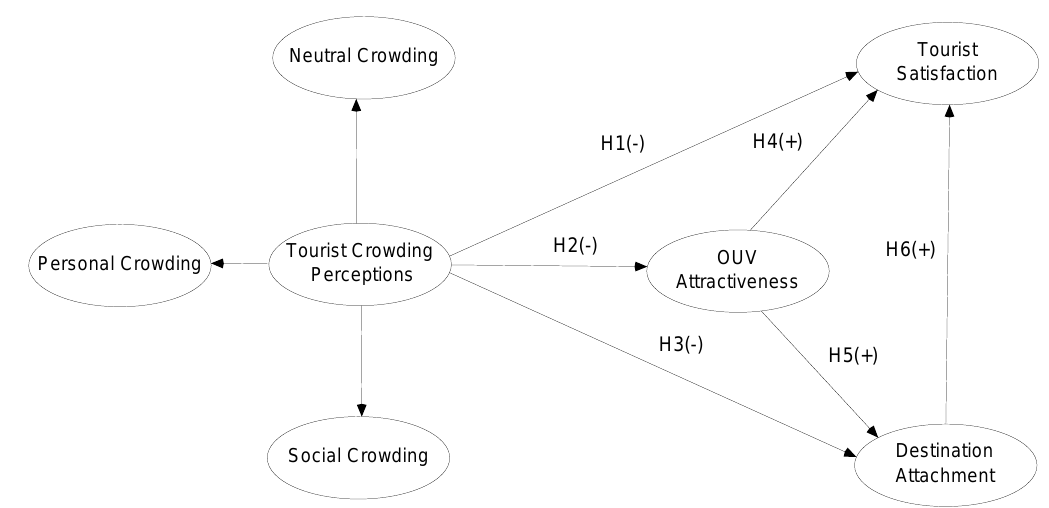
Figure 1. The suggested conceptual framework .